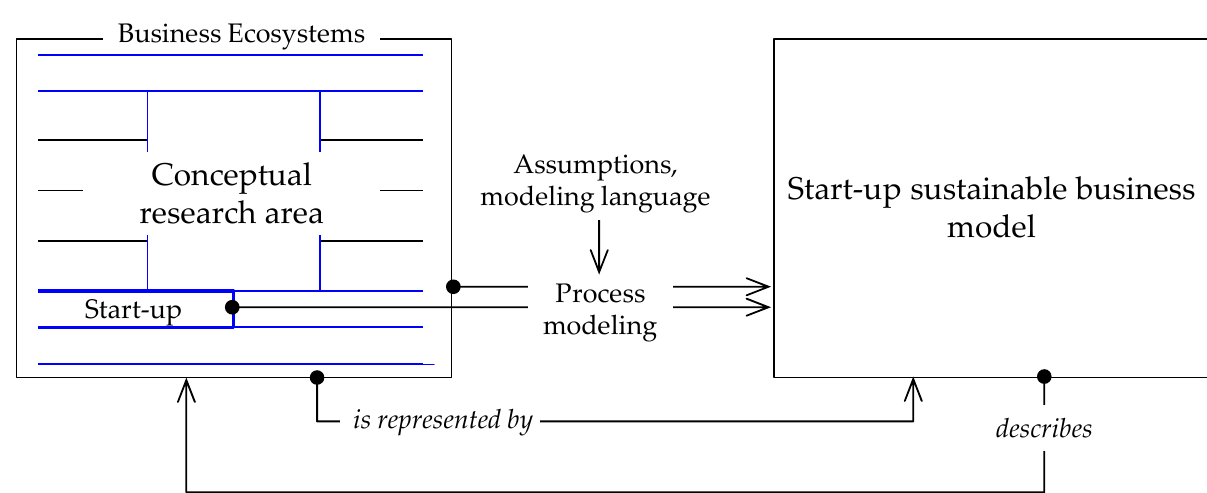
Figure 3. The research model of the process of developing a start-up’s sustainable business model. Source: author’s own development.